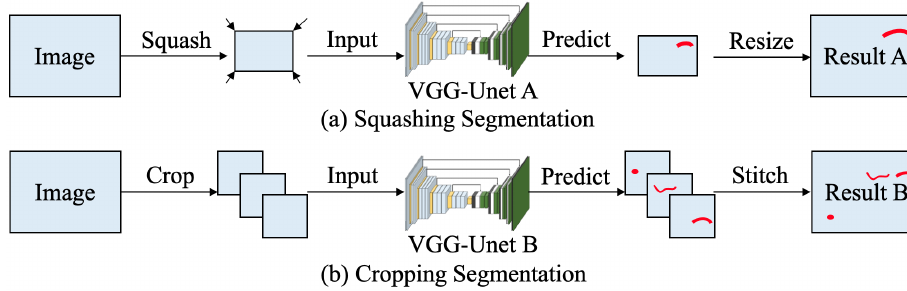
Figure 8. The predicting process of Damage Segmentation.